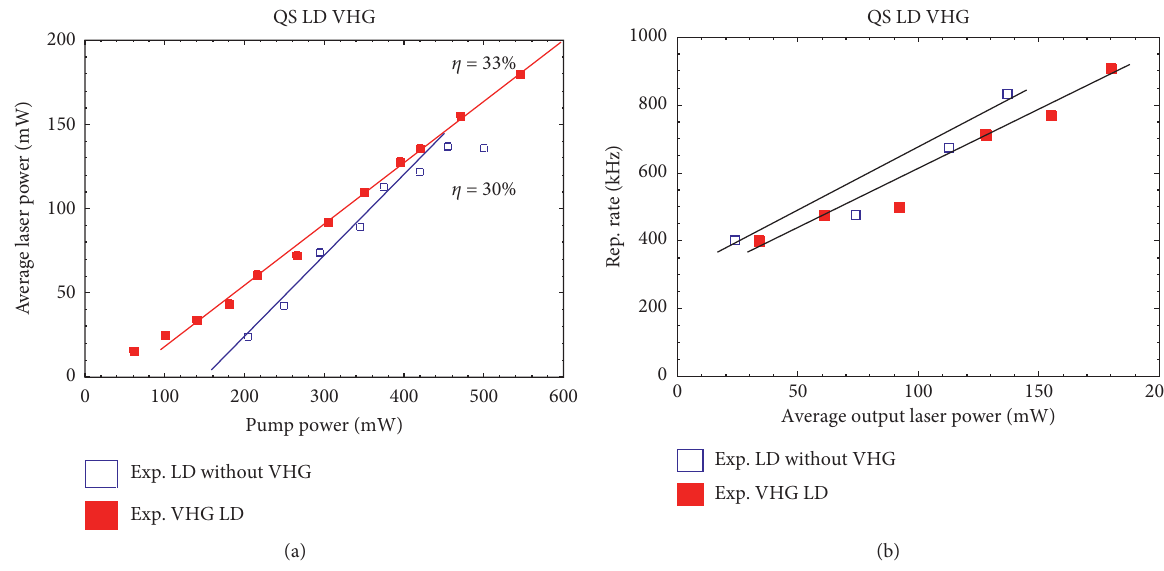
Figure 9: Nd:YVO 4 laser under pulse operation: (a) average output laser power and (b) repetition